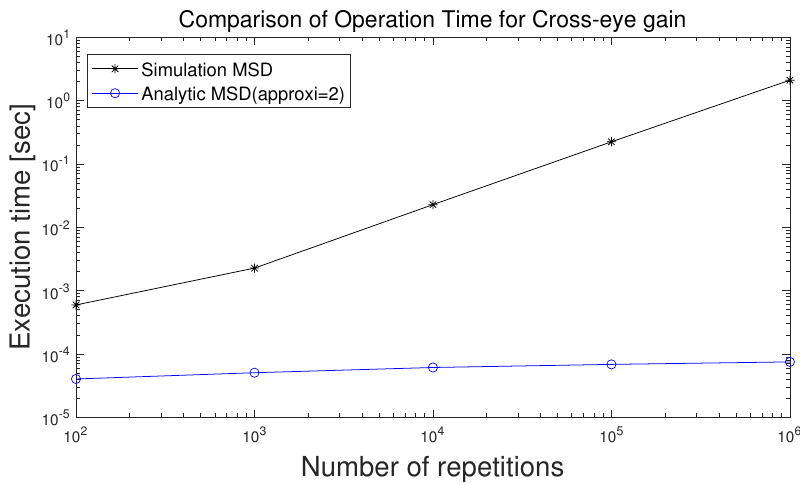
Figure 1. Execution time of MSD of cross-eye